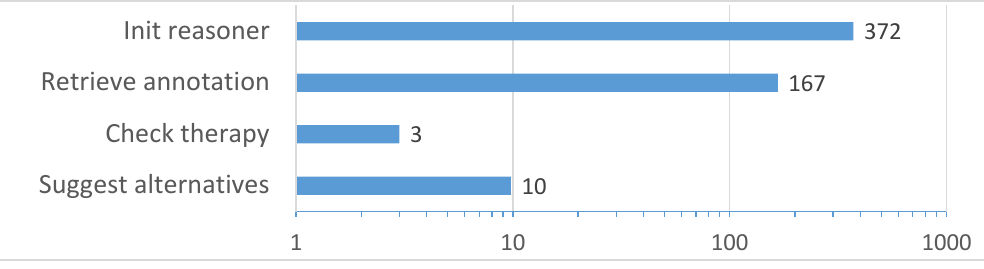
Figure 10. Processing time